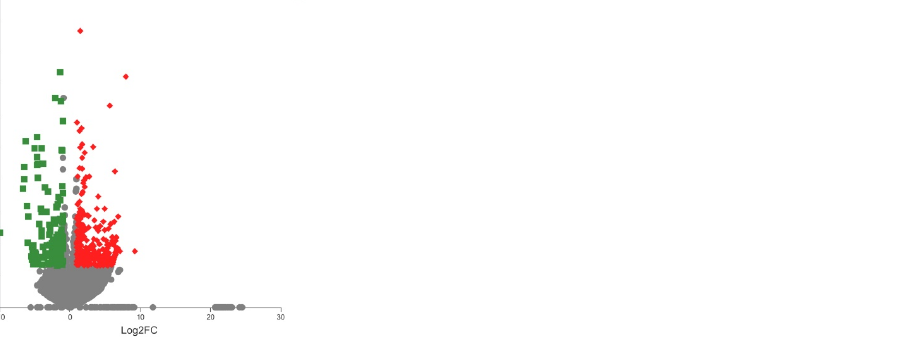
Figure 3. Functional classification analysis of the identified DEGs. ( A ) GO annotation analysis of the DEGs. The DEGs were classified into different GO terms according to biological process, molecular function, and cellular component. ( B ) KEGG pathway annotation analysis of the DEGs. The DEGs were categorized into various KEGG pathways according to metabolism, genetic information pro- cessing, environmental information processing, and cellular processes. Figure 4. GO and KEGG pathway enrichment analysis of the identified DEGs. ( A ) Top20 of GO term enrichment. ( B ) Top20 of KEGG pathway enrichment. The y − axis indicates the GO term or KEGG